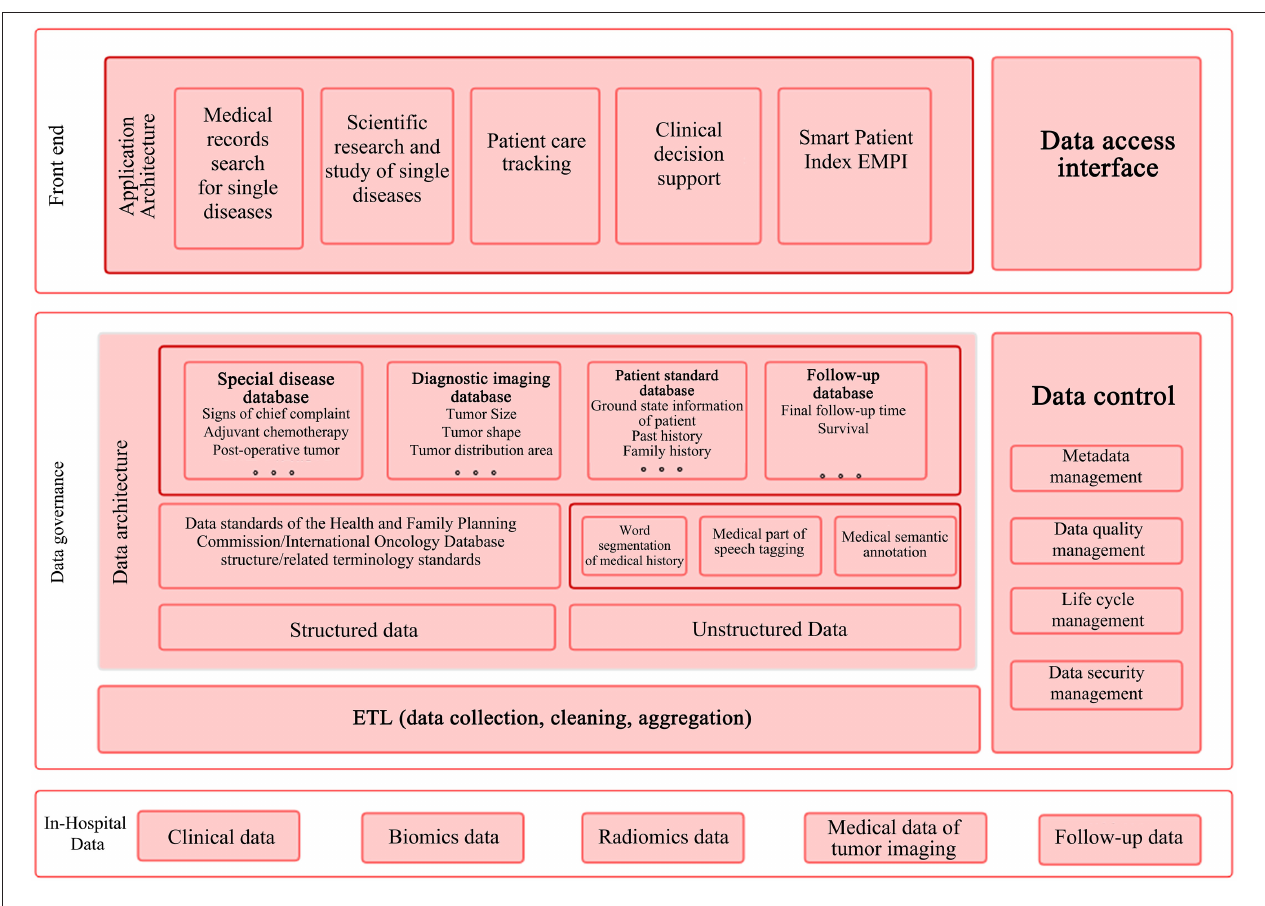
FIGURE 2 | Data governance framework. ETL,